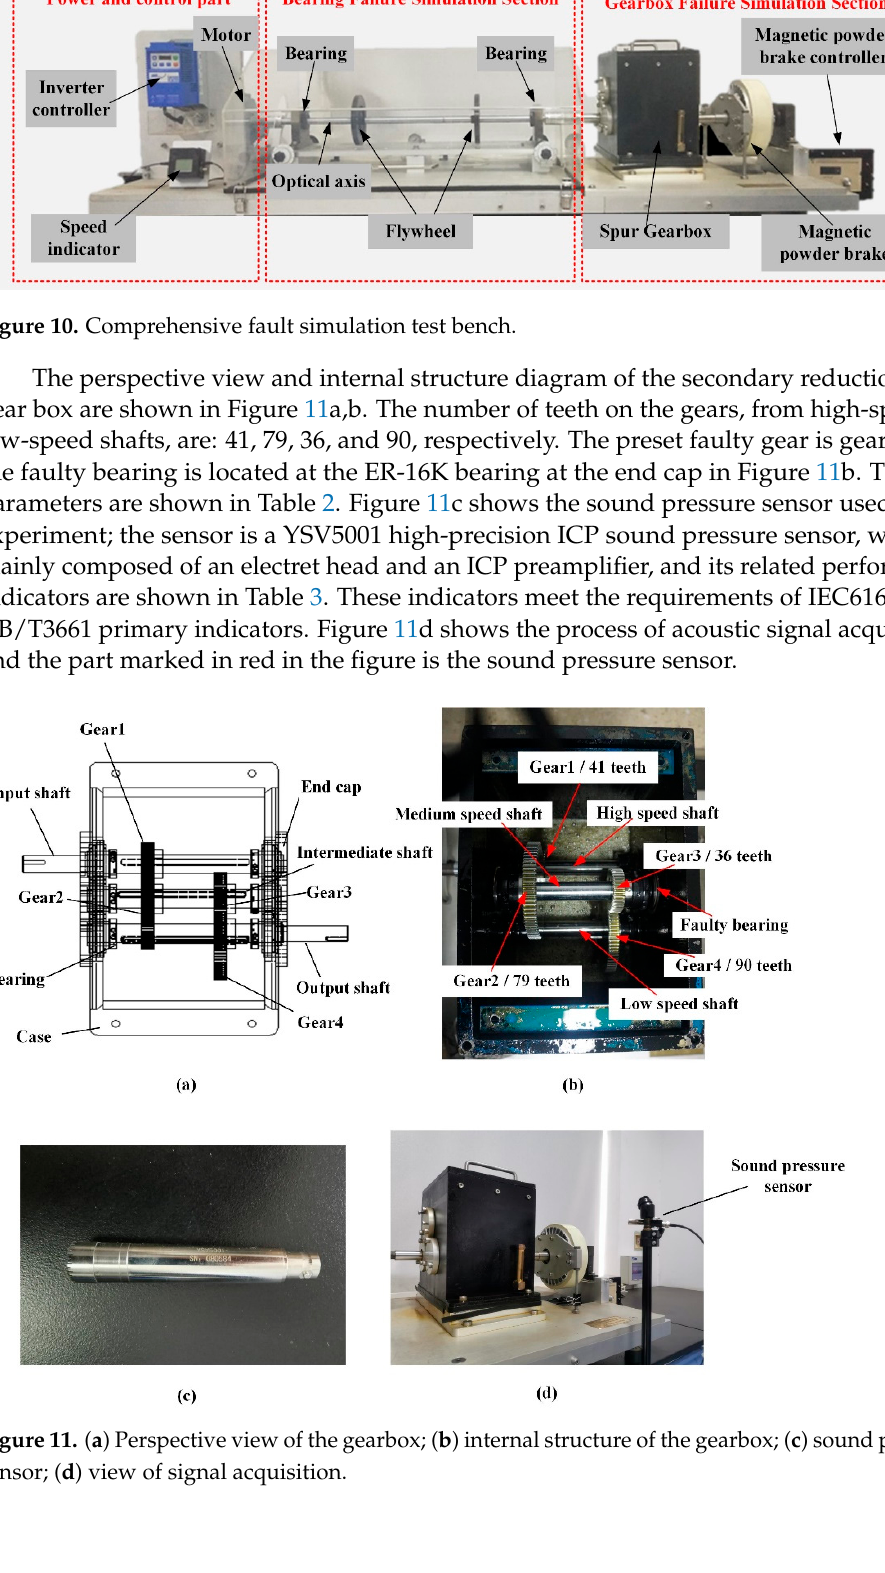
Figure 11. ( a ) Perspective view of the gearbox; ( b ) internal structure of the gearbox; ( c ) sound pres- sure sensor; ( d ) view of signal acquisition. sensor; ( d ) view of signal